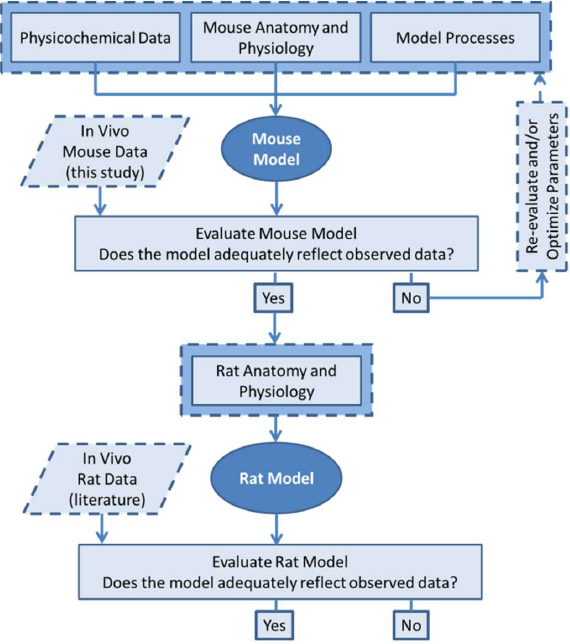
Figure 1. Physiologically-based pharmacokinetic (PBPK) modeling workflow.